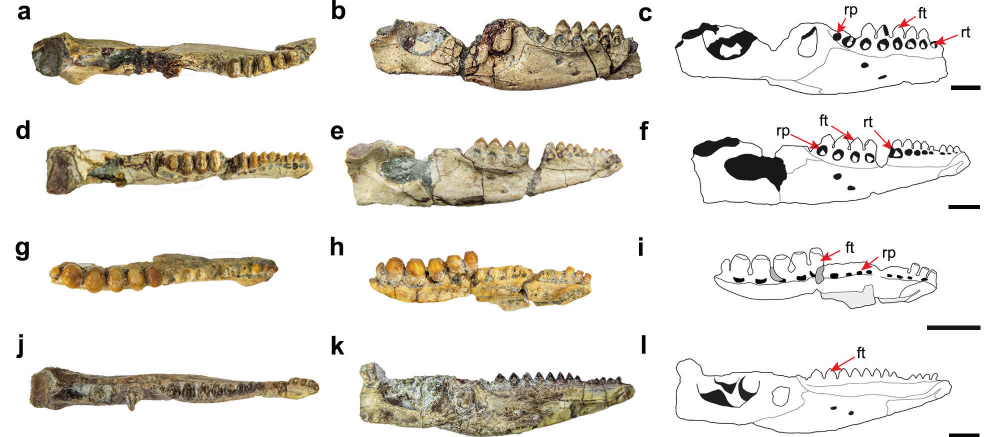
Figure 4 - Occlusal and lingual views of lower jaws; a - c IGM4978; d - f IGM4975; g - i IGM4981; j - l IGM4970a. Scale bars equals